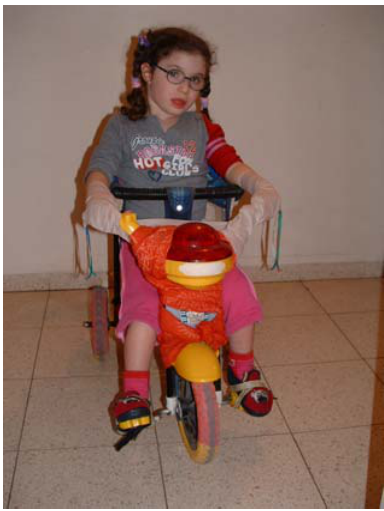
PICTURE 27 . Using the bike as a sensory